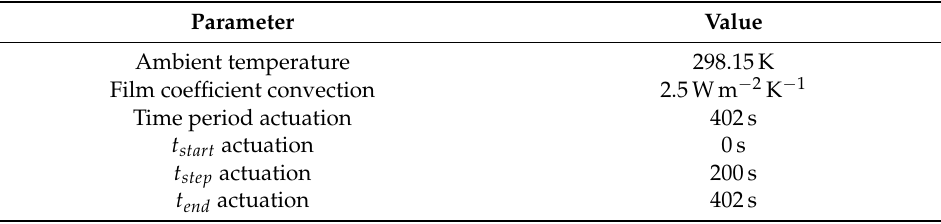
Table A2. Step and load data of the